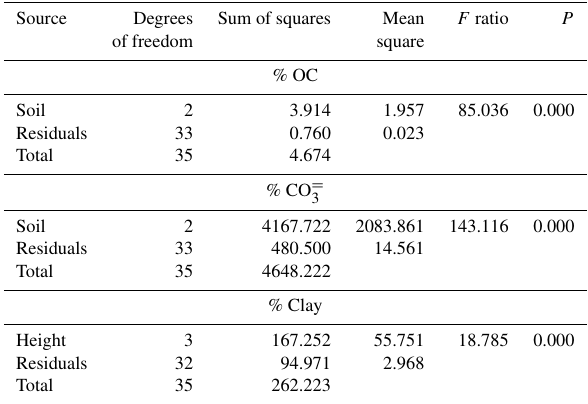
Table 3. Summary table for the ANOVAs of % OC, % CO = % clay.